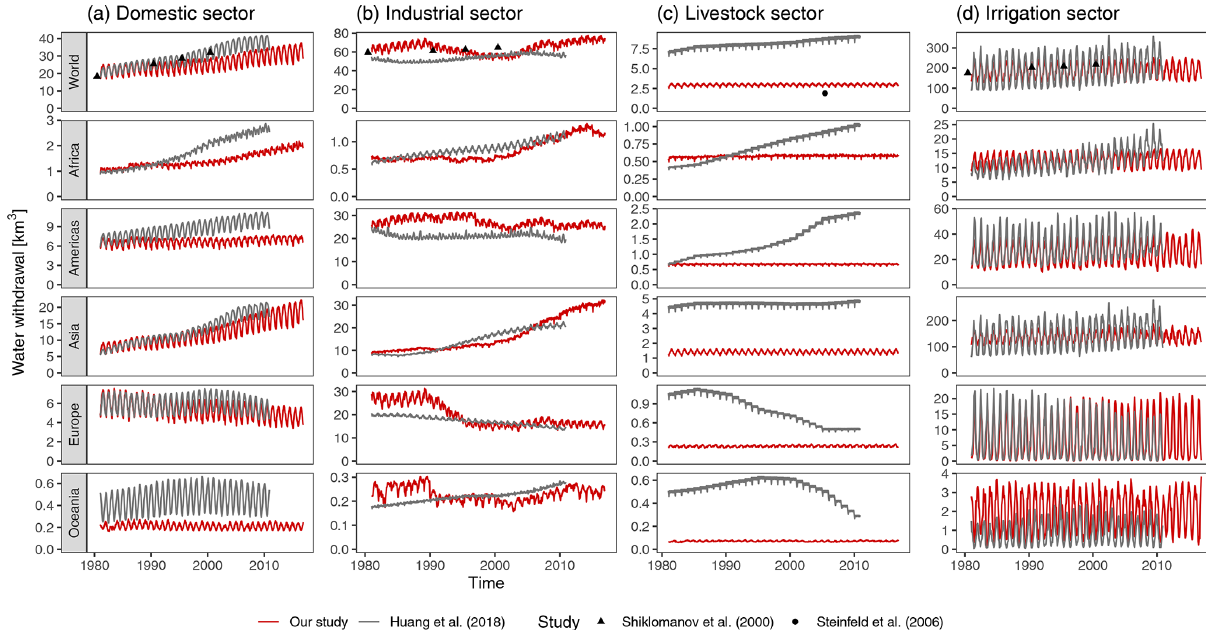
Figure 3. Comparison between the simulated monthly regional water withdrawal and values from Huang et al. (2018), Shiklomanov (2000), and Steinfeld et al. (2006) for the (a) domestic, (b) industrial, (c) livestock, and (d) irrigation sectors. Colours and shapes distinguish between studies. Note that the jitter in livestock withdrawals is due to the different days per